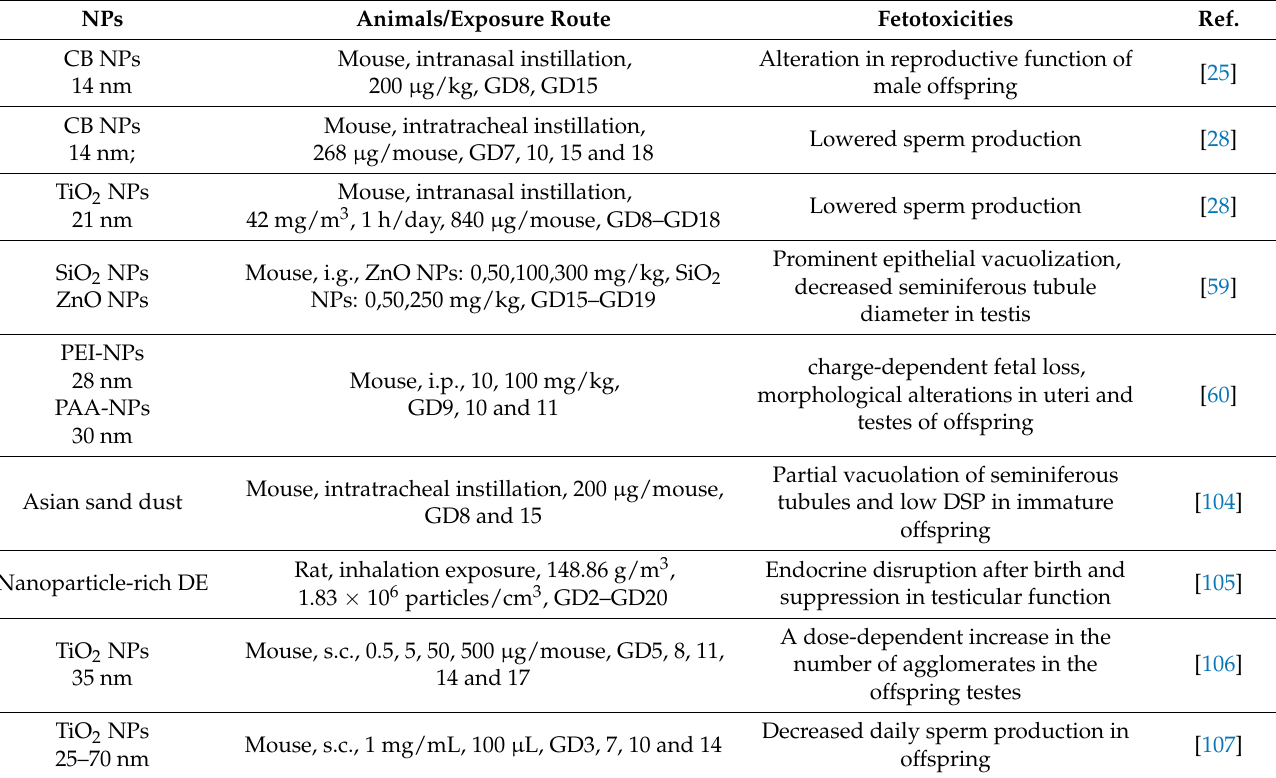
Table 3. NP-induced reproductive toxicity following maternal exposure during